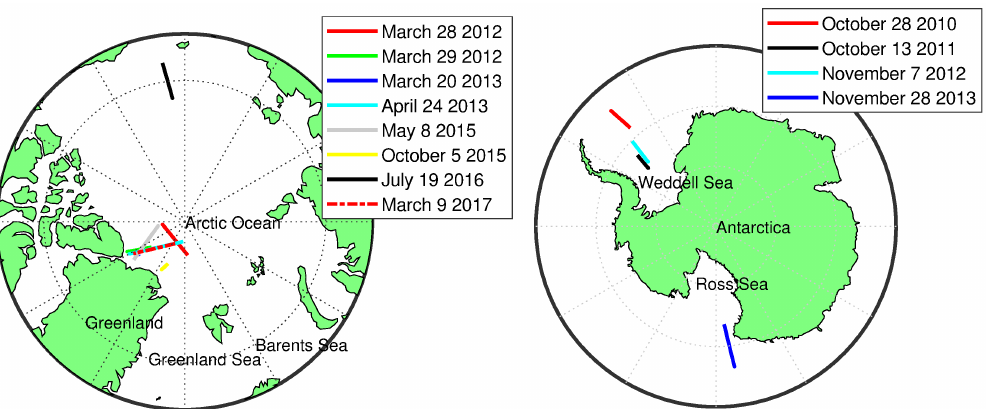
Figure 1. Illustration of Operational IceBridge (OIB) flight lines taken for validation in the Arctic Region ( left ) and the Antarctic Region ( right